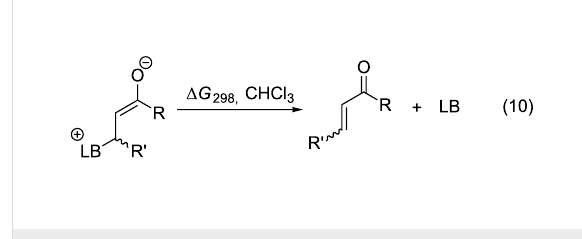
Scheme 10: Reaction for the Michael-acceptor affinity (MAA) of a Lewis